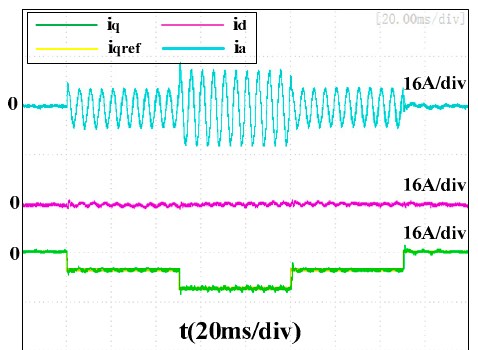
Figure 24. d-q axis current waveform of the proposed accurate discrete current controller at 12,000 rpm with Kdq = 500 π Ls , ˆ L s = 1.2 L s .